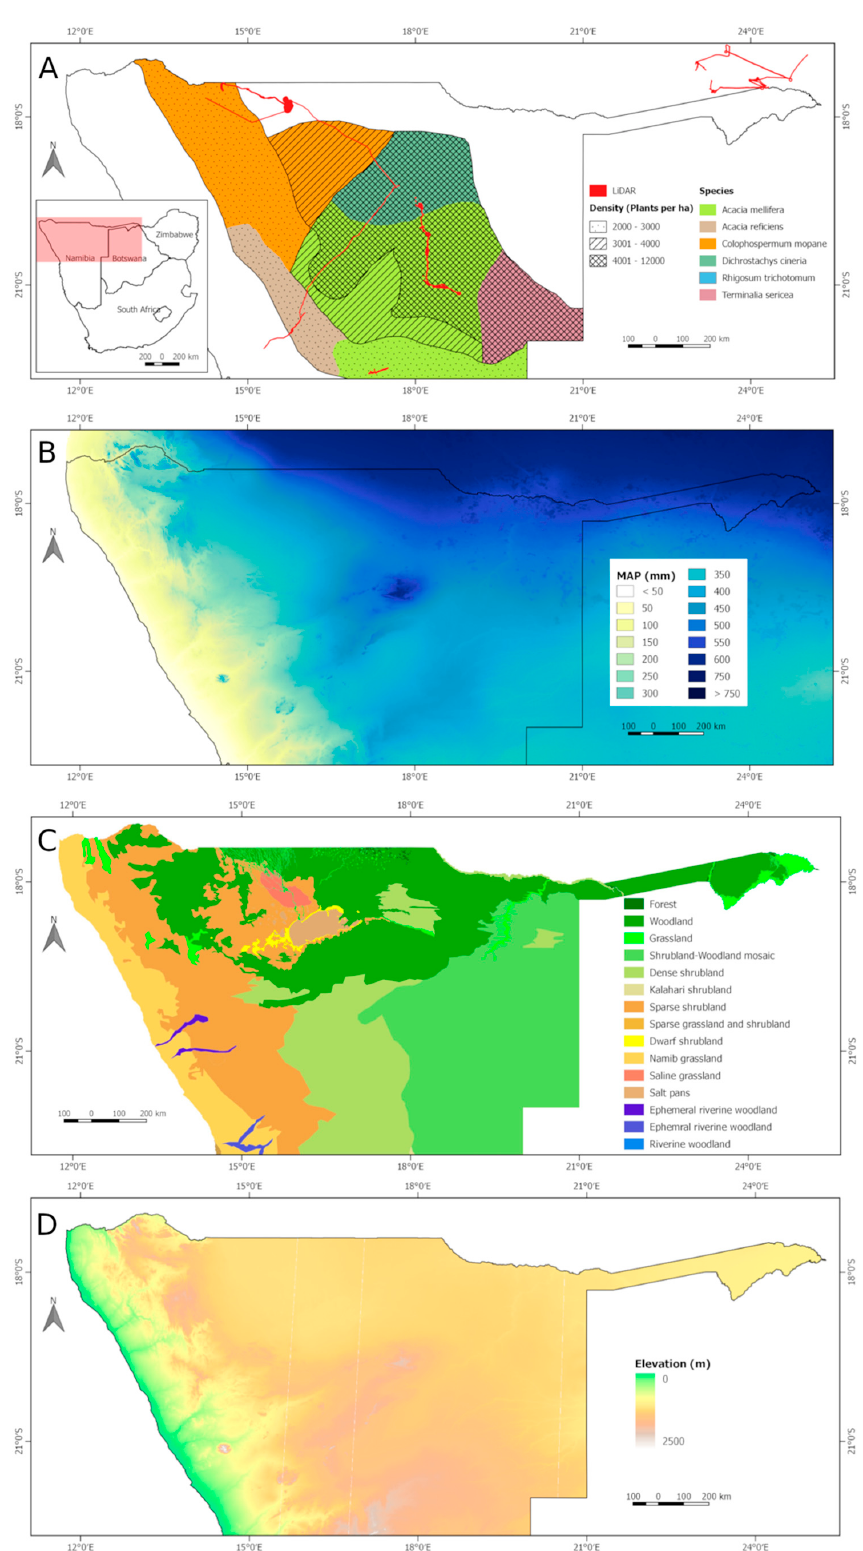
Figure 1. Study area in northern Namibia (Inset). ( A ) Bush encroachment mapped as density of plants per hectare and species (after [19]), as well as LiDAR data extent (red). ( B ) Mean annual precipitation (MAP) (WorldClim v2) [56]. ( C ) Vegetation structural classes [54]. ( D ) Elevation [57].